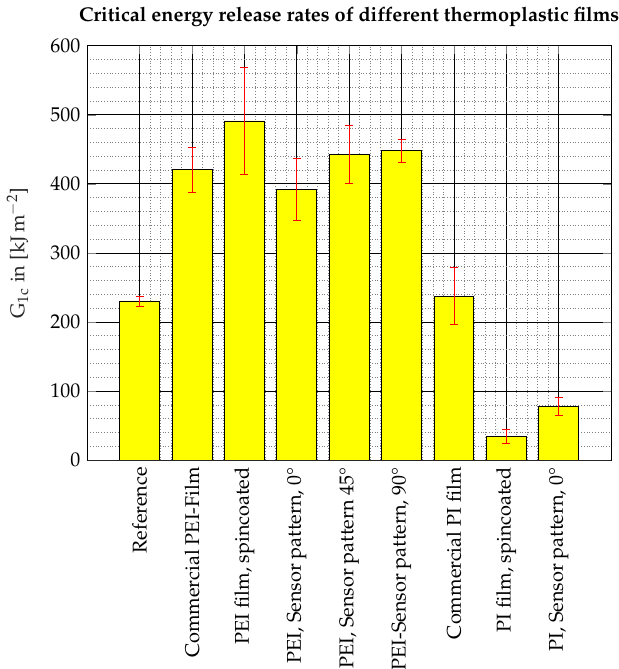
Figure 10. Critical energy release rates from DCB tests for different film materials and different orientations of a universal sensor structure. The data on the reference specimens and the commercial PEI and PI film is from